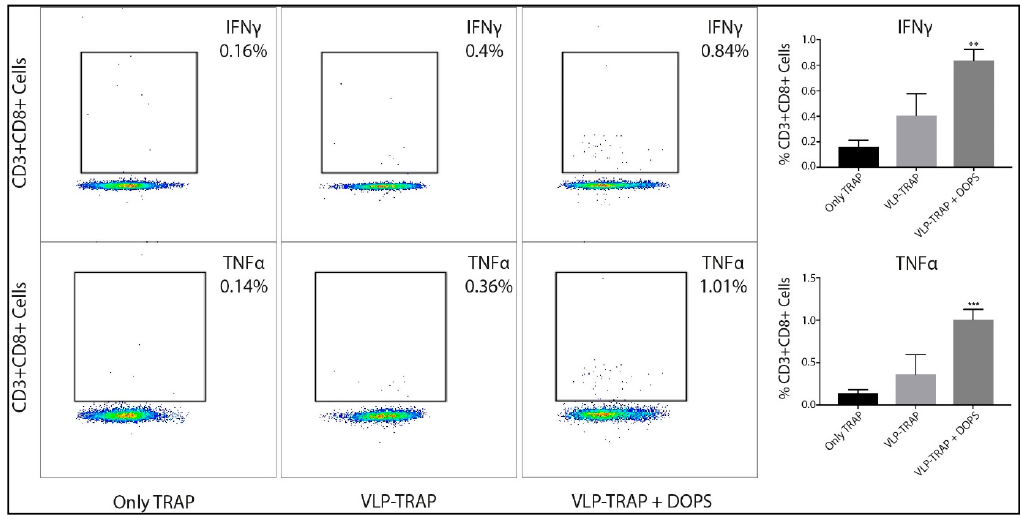
Figure 6. Assessment of TRAP-specific CD8 + T cell responses in CD1 mice. As described in Figure 1, mice were immunized three times every three weeks and bled on day 50 (eight days after the third vaccination) and the PBMC cells were stimulated with immunodominant Pb9 peptide to assess production of IFN γ and TNF α by CD8 + T cells. As seen in the figure above, the group of mice vaccinated with VLP-TRAP + DOPS was able to produce more IFN γ and TNF α than the groups of mice vaccinated with TRAP protein either VLP-TRAP. Note: *** p -value < 0.0001; ** p -value < 0.001. To assess vaccine-induced protection, CD1 mice were infected with transgenic P. berghei expressing TRAP of P. falciparum , as described above. As seen in the Figure 7, mice vaccinated with CuMVtt-TRAP + DOPS showed a delay in parasitemia and even sterile protection was observed in some. To consider protection as sterile, mice should not have any erythrocytes infected until 14th day after challenge. The mice were observed for an additional two weeks to check for any signal of disease. At the end of each experiment the mice were